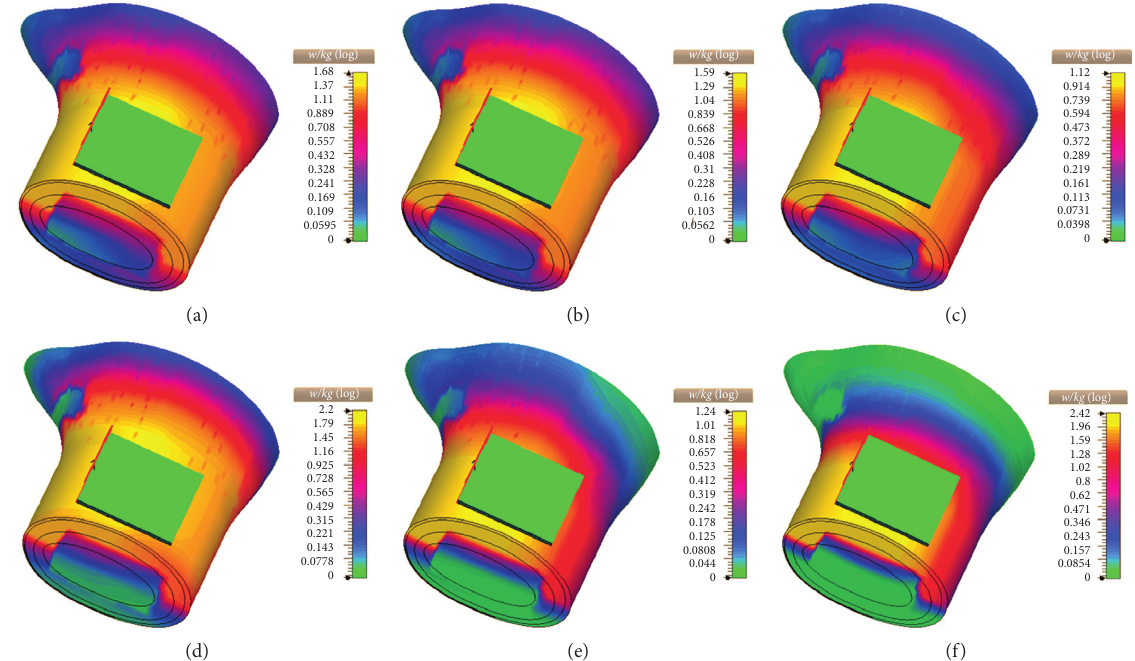
Figure 16: SAR distribution in W/kg averaged over 10g along hand wrist tissue, for a spacing d � 2mm. (a) 2.3GHz. (b) 2.4 GHz.